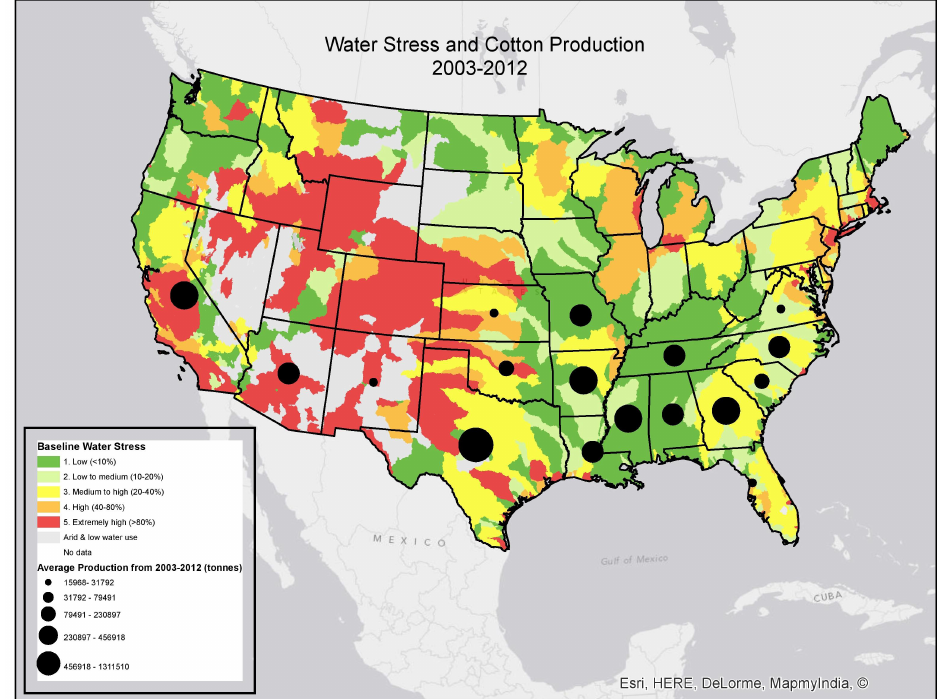
Figure 5. Water Stress and Cotton Production Source: U.S. Geological Survey National Water Information System, https://waterdata.usgs.gov/nwis [9].